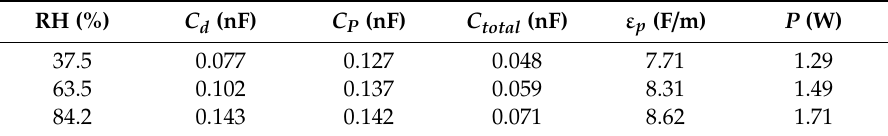
Table 1. Analytic results of the family of Q ∼ V